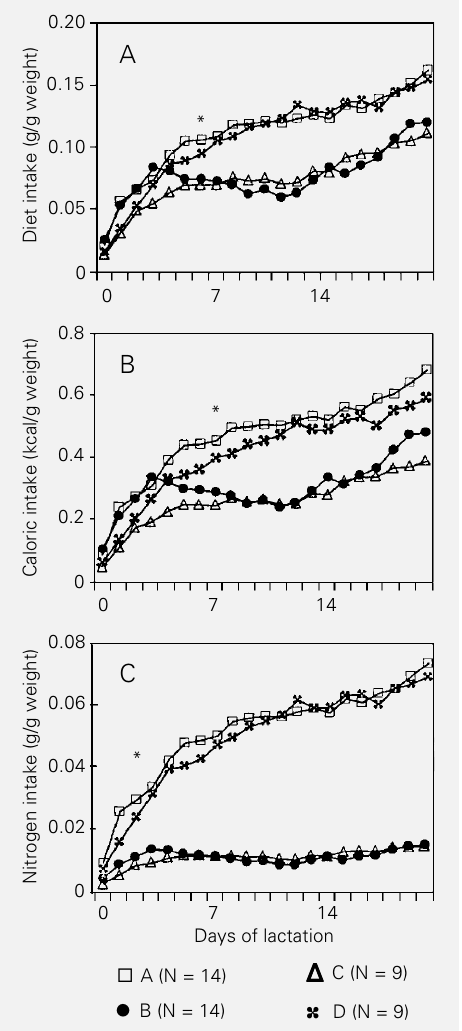
Figure 1 - Feeding performance (g food intake/g body weight) of dams during lactation. Values are the means for all rats receiv- ing each diet on each day of lac- tation. A , Diet intake; B , caloric intake; C , nitrogen intake. *P<0.05 for diets A and D compared to diets B and C (Kruskal-Wallis test and Student- Newman-Keuls test for